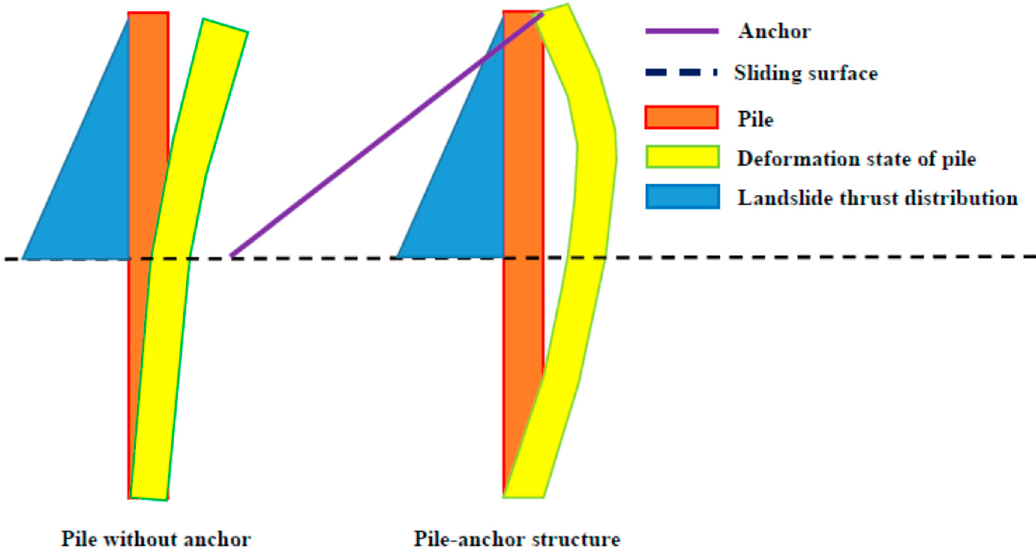
Figure 12. Deformation state of pile in different support structure systems.